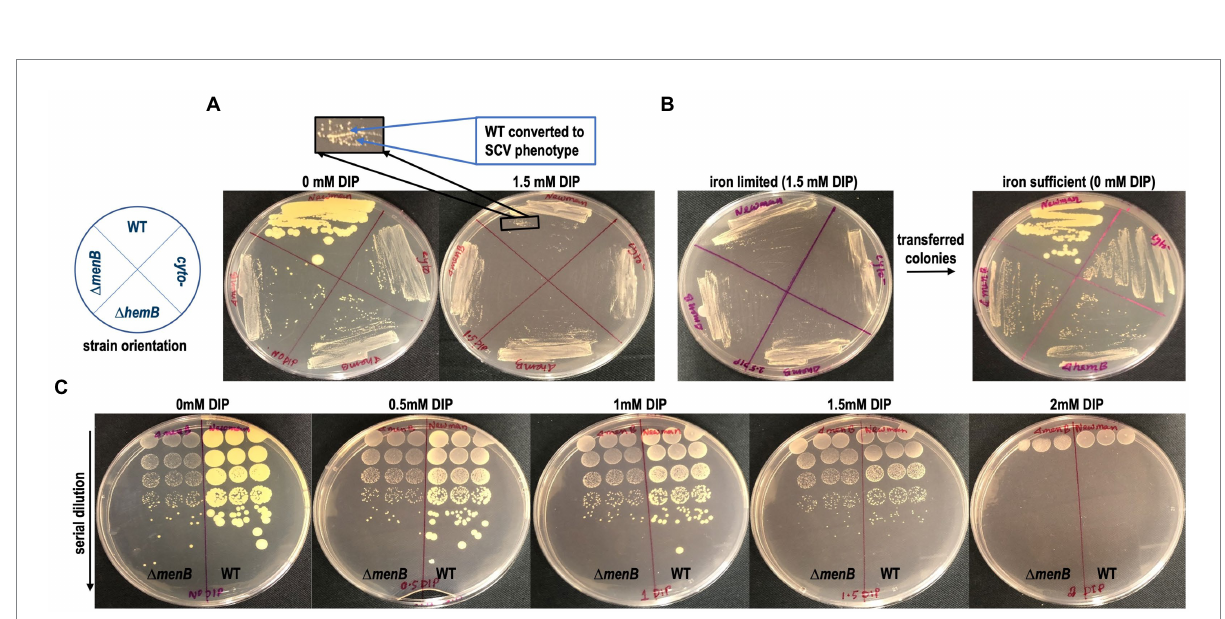
FIGURE 2 Transient SCV phenotypes are induced in genetically WT Staphylococcus aureus during iron restriction. (A) WT colonies on TSA are larger and more pigmented than SCV colonies yet are indistinguishable from SCV colonies when grown on TSA supplemented with DIP. (B) The SCV conversion is a physiological adaptation to iron limitation rather than a genetic conversion to SCV form as the cells immediately revert to their large, pigmented colony form when subcultured onto iron replete TSA plates. (C) The SCV conversion occurs over a large concentration range of DIP treatment and is identical to the SCV conversion induced by anaerobic growth. These plates are representative of data observed on multiple plates cultured on at least 3 separate